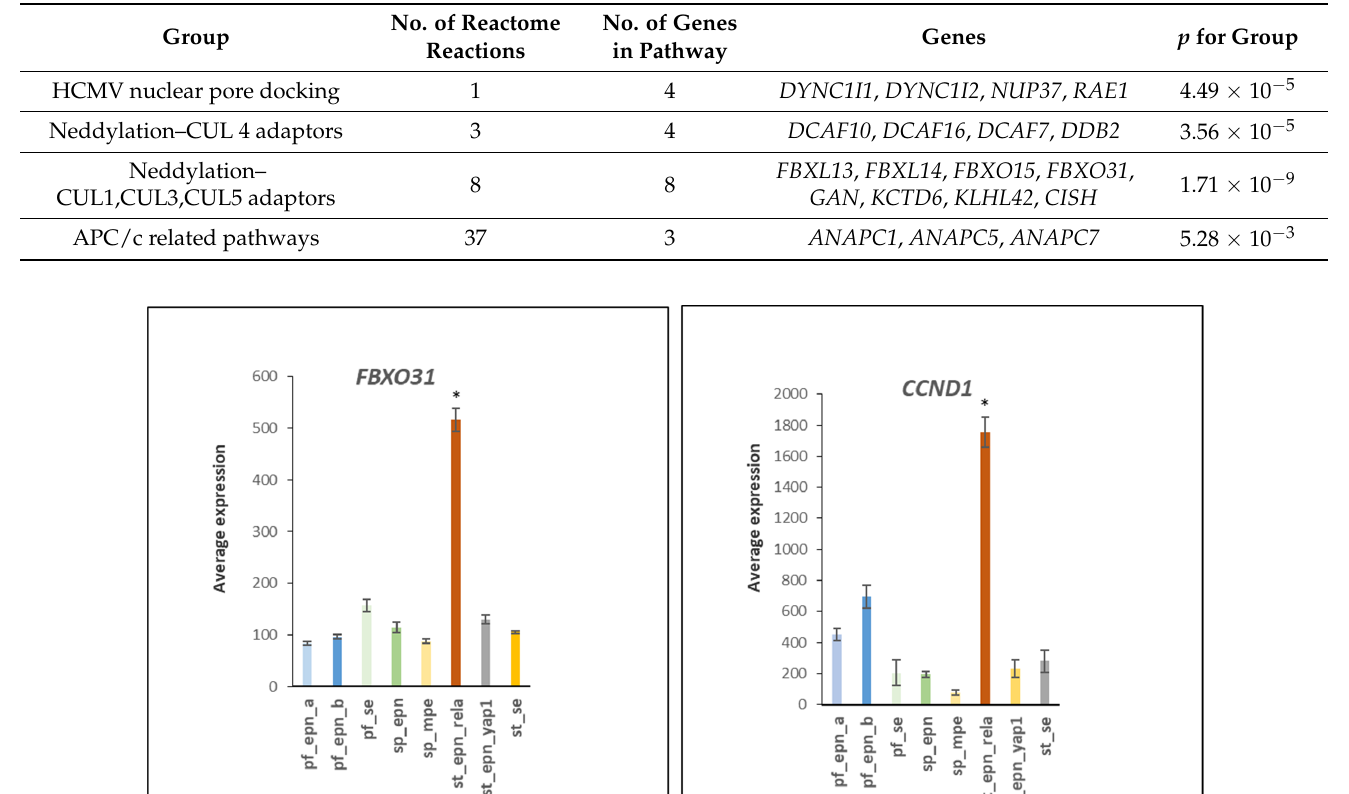
Figure 19. Elevated gene expression of KCTD6 (pf_epn-a) and GAN (pf-se) (by Anova F = 21.73, p = 1.023–21 and F = 33.29, p = 1.71 × 10 − 30). * by t -test significantly different from other groups p < 0.001, for KCTD6 and p < 0.01 for GAN. Dataset GSE64415. Currently, little is known about the regulation and functional impact of neddylation of E3 ligases and adaptors in EPN. An increase in the expression of the protein SCCRO3 encoded by DCUN1D3 (Defective in Neddylation 1D3) was shown to reduce neddylation of F-Box ubiquitin ligases (Cullin 1 ligases). SCCRO3 regulates neddylation by binding to CRL1 ligases and the protein CAND1 to block the nuclear translocation of E3 ligases [46], which contributes to cell cycle progression upon UV damage [47]. In the EPN dataset, expression of the DCUN1D3 gene was elevated in the SP_MPE subgroup (F = 11.62, p =